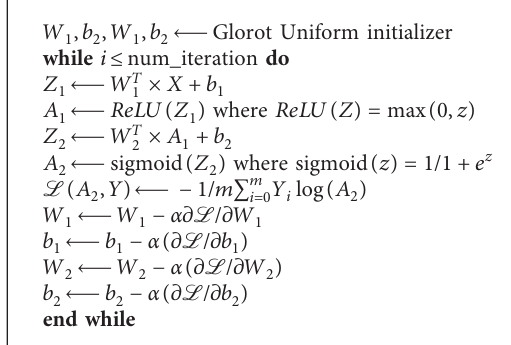
A LGORITHM 1: Training in Shallow Neural